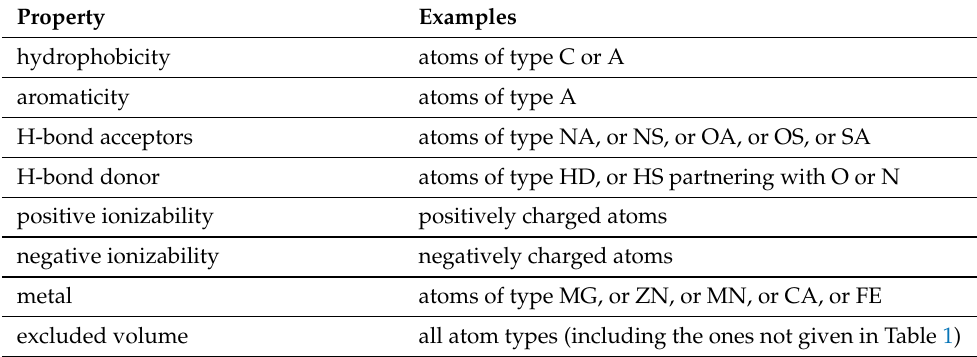
Table 2. Chosen types of atoms arranged into eight